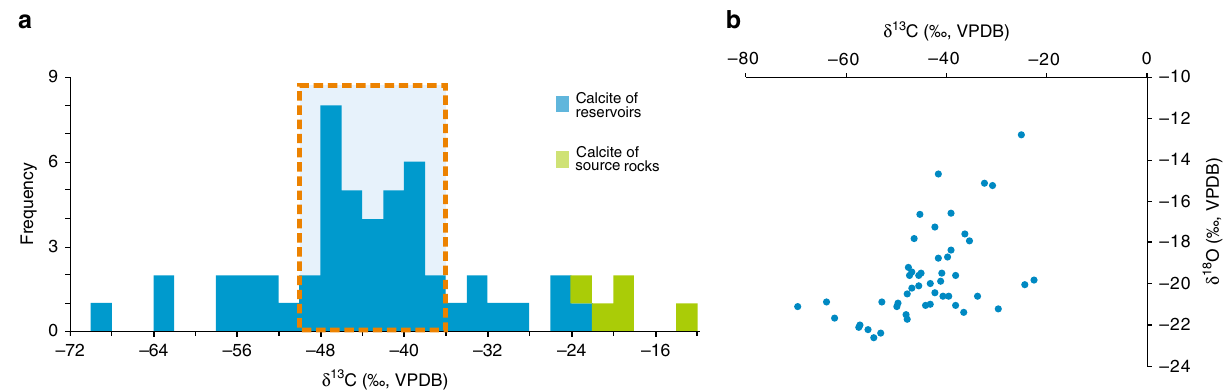
Fig. 4 Carbon and oxygen isotopic compositions in authigenic calcites. a Histogram of δ 13 C values, of calcite cements in T 1 b reservoirs, and calcite veins in P 2 w source rocks. b Crossplot of bulk rock δ 13 C and δ 18 O values in T 1 b calcite cements. The error bar (±SEM) is smaller than the symbol size. Source data can be seen in Supplementary Data